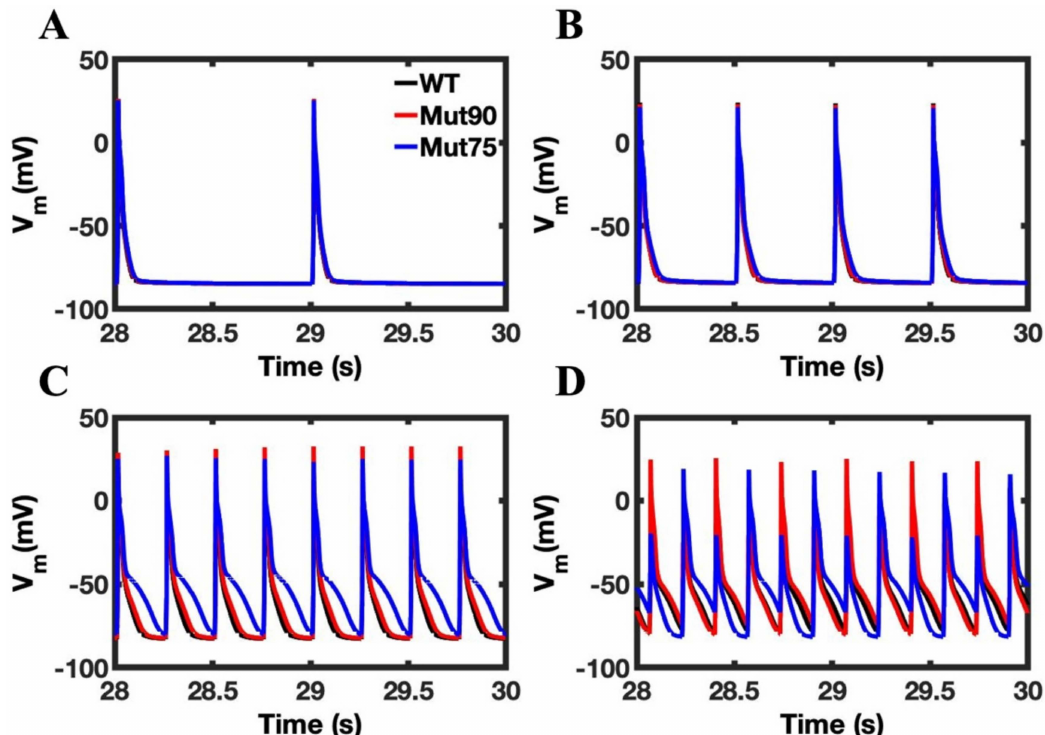
Figure 6. Transmembrane voltage in simulation of cardiac myocytes: ( A ) 1 Hz pacing, ( B ) 2 Hz pacing, ( C ) 4 Hz pacing, ( D ) 6 Hz pacing. Simulations of the wild-type (black) cardiac myocyte and cardiac myocyte with mutant CDI (75% of transition rate—blue and 90% of transition rate—red) show that the transmembrane voltage for the cardiac myocyte displays a slight elongation of the action potential during pacing. APD alternans is seen for the